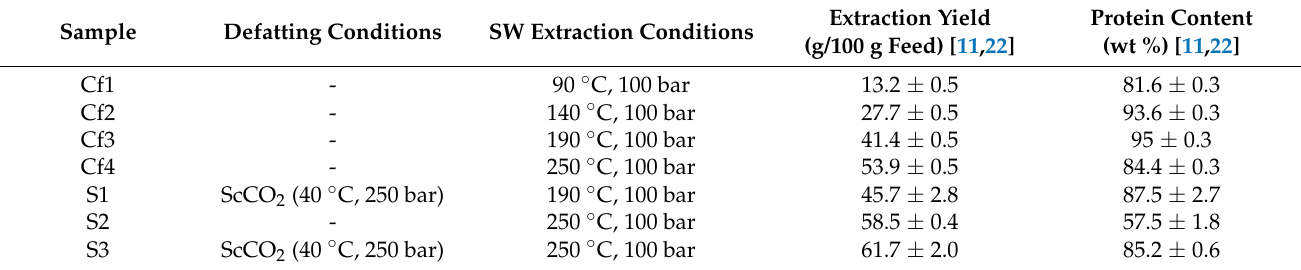
Table 1. Extraction process techniques and parameters used for each sample. Extraction yield and protein content are expressed as mean ± standard deviation